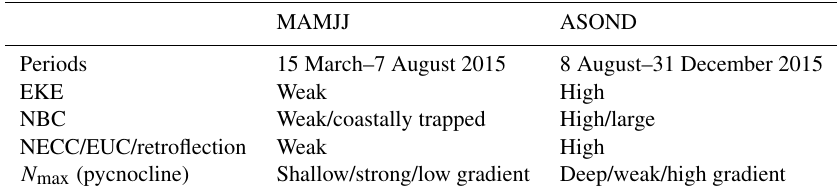
EKE Weak High NBC Weak/coastally trapped High/large NECC/EUC/retroflection Weak High N max (pycnocline) Shallow/strong/low gradient Deep/weak/high